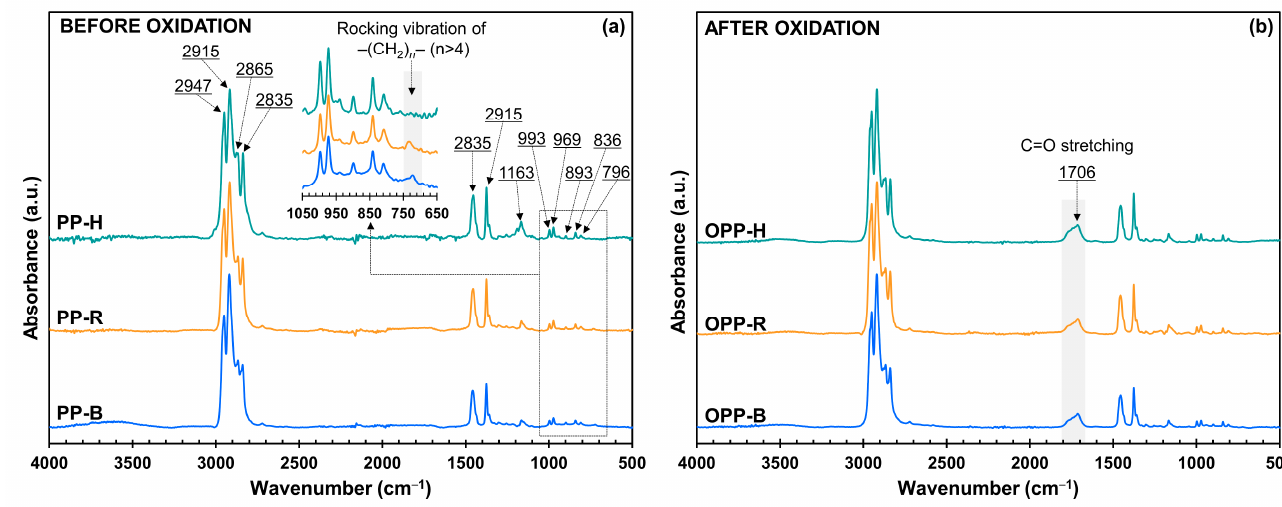
Figure 2. FTIR spectra of PP granules including homopolymer, random copolymer, and block copolymer ( a ) before and ( b ) after oxidation in the wavenumber range 4000–500 cm Table 3. FTIR characteristic peak wavenumbers of PP before and after oxidation.